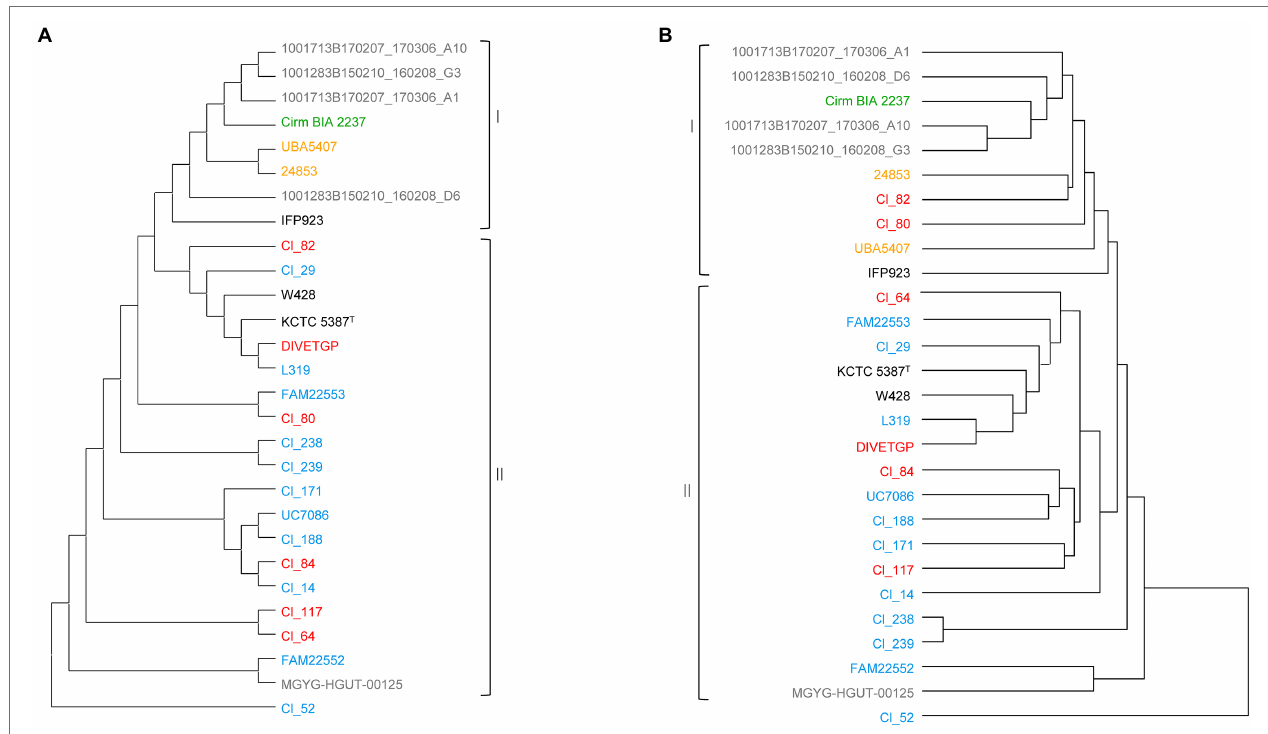
FIGURE 2 | Phylogenetic analysis of 28 Clostridium tyrobutyricum strains. (A) Maximum-likelihood (ML) phylogenetic tree based on 1,179 single-copy gene families using 500 bootstrap replications. (B) Pangenome tree based on presence/absence of gene family in all genomes. The strain names are colored according to their isolation source, where red, blue, green, gray, and orange denote milk, cheese, silage, human, and mud, respectively. The type strain is indicated by the superscript capital T. The phylogenetic trees were visualized using MEGA X v10.1 (Kumar et al.,